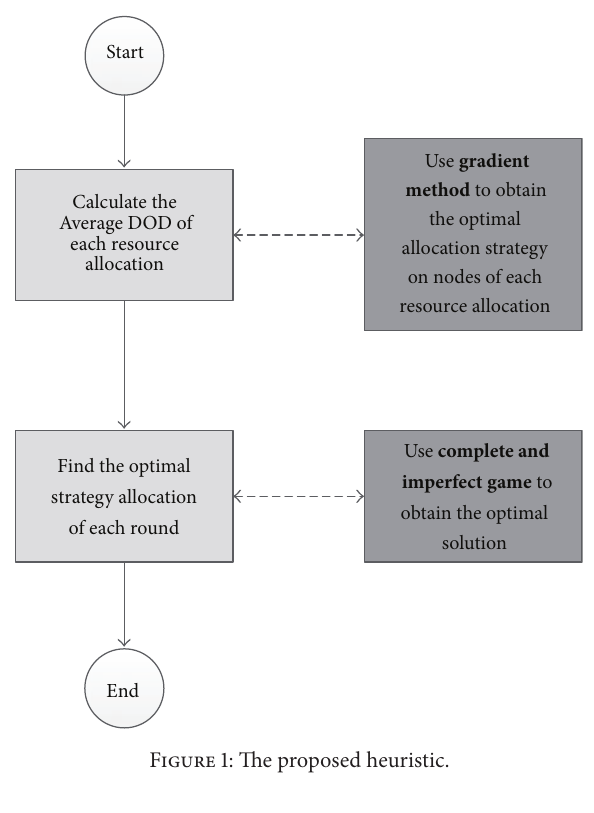
Figure 1: The proposed heuristic.